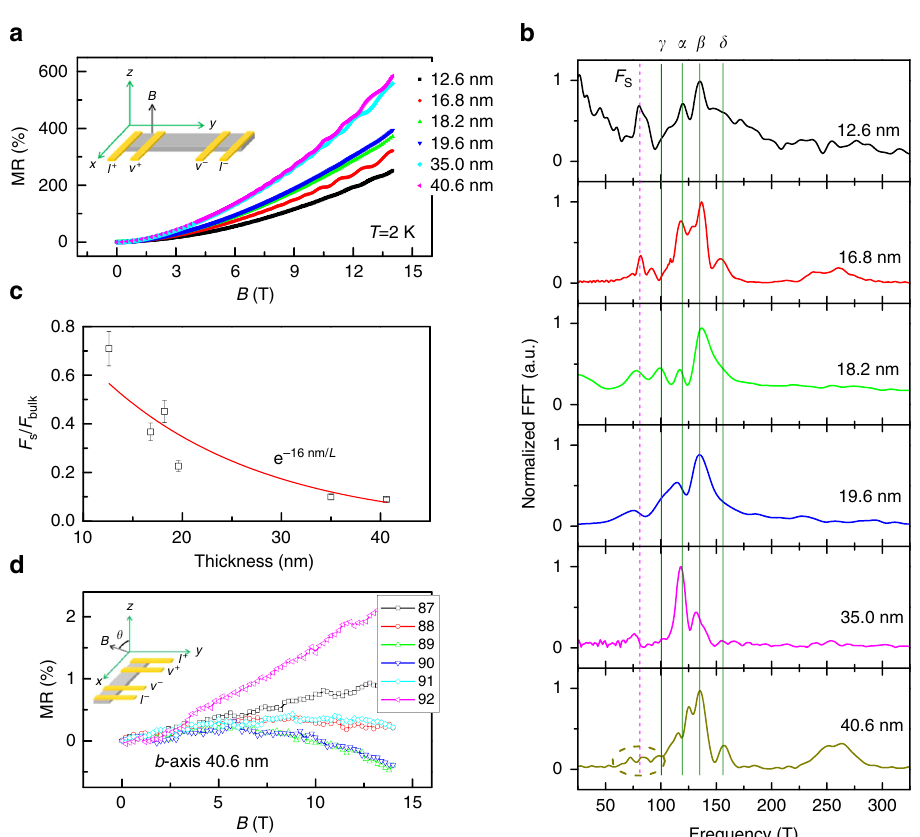
Fig. 4 Thickness-dependent Weyl orbit oscillations. a The MR of b -axis ribbon with different thicknesses. b The FFT spectra of b -axis ribbons with different thicknesses, in which the spectra are normalized with respect to the strongest frequency of electron pocket β . The Weyl orbit frequency almost vanishes in 40.6 nm thick ribbon. c Thickness dependence of the relative amplitude of the Weyl orbit oscillation and the bulk oscillation with respect to peak β . The thickness dependence of relative amplitude can be fi tted by e (cid:4) L 0 = L , with L 0 = 16.0 nm. The fi tted value of L 0 is in the same magnitude of the mean free path ( c -axis) ~48.0 nm. The 20% error bar was added given to the FFT frequency spacing estimate. d The chiral-anomaly-induced negative MR in 40.6 nm thick b -axis